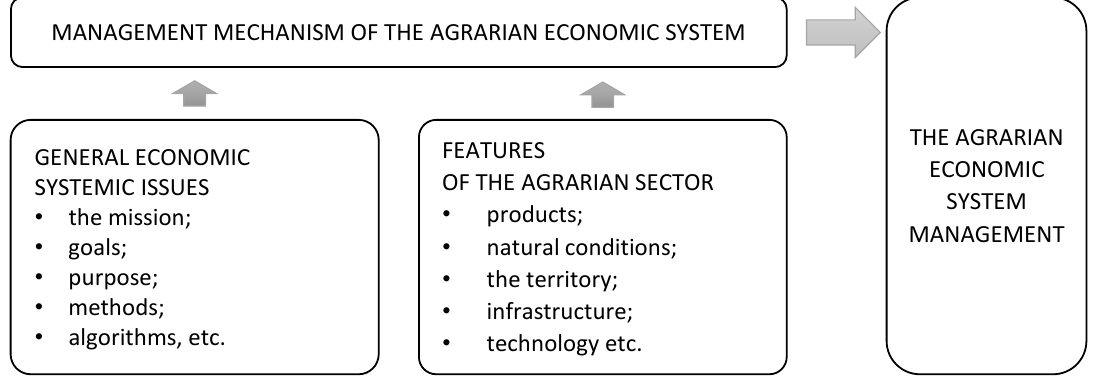
Figure 3. The structure of the agrarian economic systems management